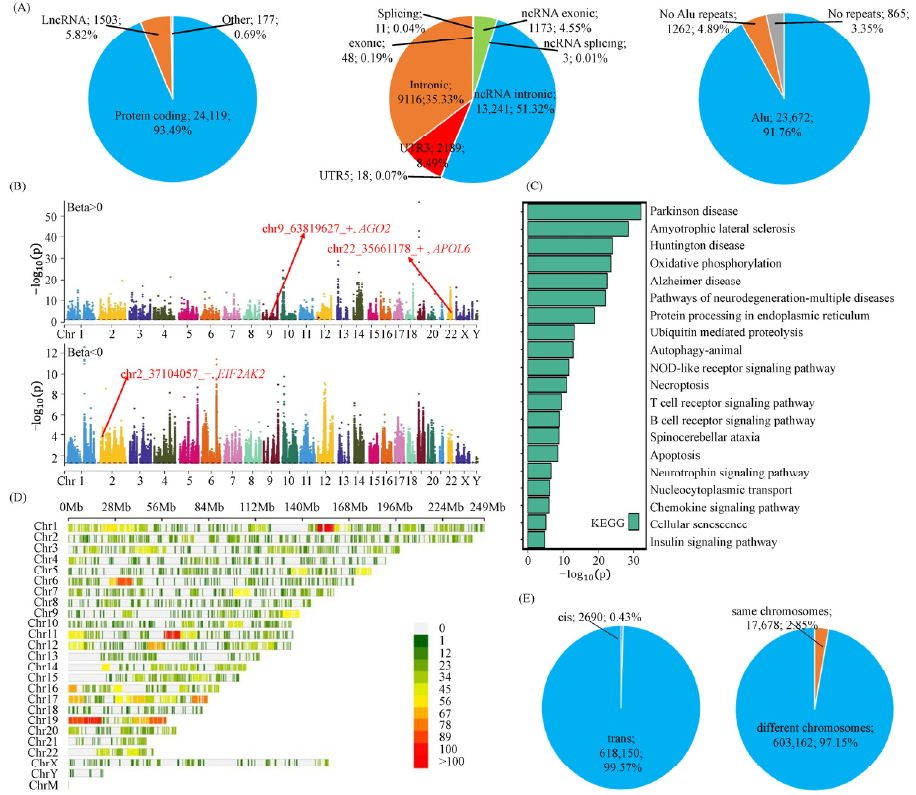
Figure 2. The overview of RNA editing effects on gene expressions. ( A ) The distributions of informative RNA editing events in genes, regions, and repeats. ( B ) Manhattan plots show the effects of 9897 RNA editing events on 6286 genes by QTL (FDR < 0.05) and Pearson correlation analyses ( p < 0.05). The top and bottom panels present 137,563 positive and 483,277 negative associations, respectively. ( C ) The PD-related enrichment pathways of the editing-associated genes by DAVID. ( D ) The den- sity distributions of editing-associated genes on chromosomes. The color bar shows the number of editing-associated genes in a 10 M bps (base pairs) region. ( E ) The types of editing–gene associations. Most RNA editing events are associated with distal genes (dist > 1 × 10 6 , trans-associations) and genes in different chromosomes. 3.2. A-to-I RNA Editing Events May Affect miRNA Regulations of Their Host Genes A-to-I RNA editing can modulate gene expression by altering the miRNA binding sites of the host gene. In total, there are 581 RNA editing events located in their associated genes (Figure 3A). Of them, 72 RNA editing events were predicted to create 11,370 new miRNA-binding sites and eliminate 815 original ones. The QTL and Pearson correlation results for these editing events and gene expressions are presented in Table S5.